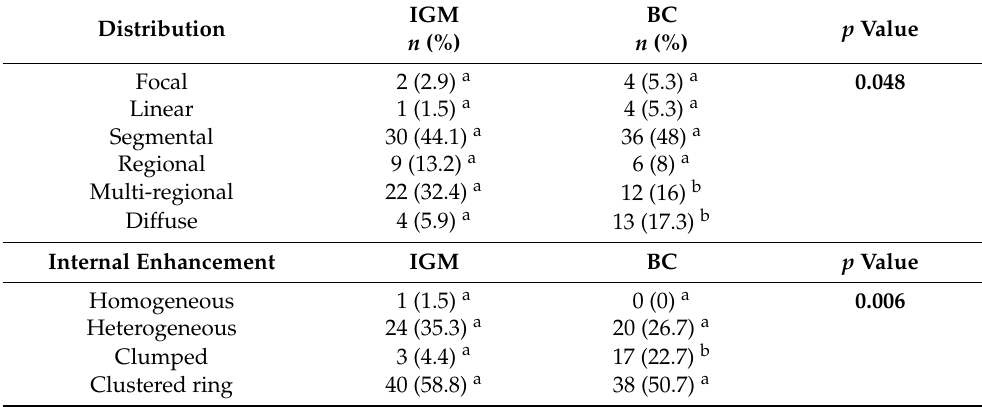
Table 3. Lesion distribution and internal enhancement characteristics of lesions presenting as non- mass enhancement.